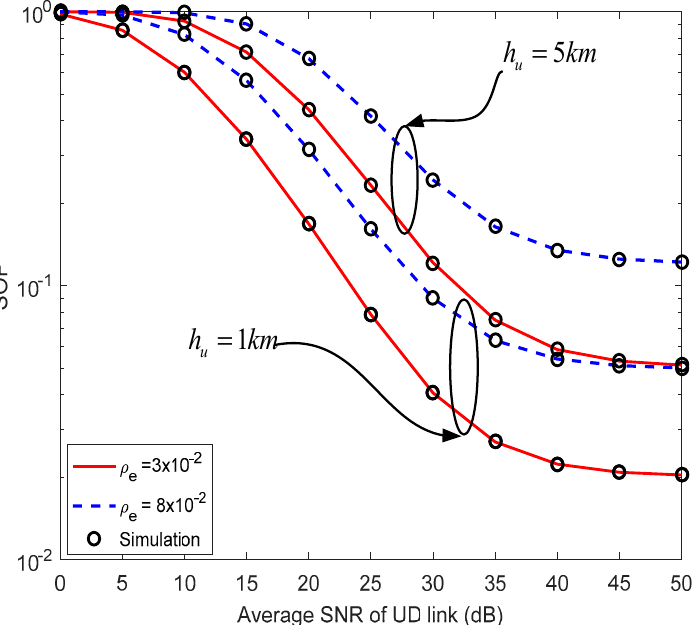
Figure 3. Impact of UAV height h u and eavesdroppers’ density ρ e on the network SOP when γ BU = 35 dB and γ UE = 10